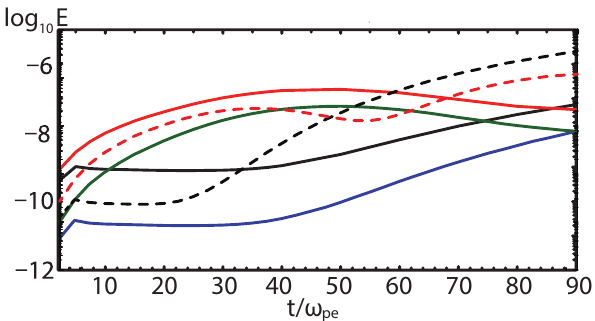
Fig. 4. The panel shows the time evolution of electric field energy (red) and magnetic field energy (black) for γ j = 15 and m i /m e = 20 (Nishikawa et al., 2013). For the case with the real mass ratio the green and blue lines shows the time evolution of electric field en- ergy and magnetic field energy, respectively. The dashed red and black lines show the time evolution of electric field energy and magnetic field energy, respectively for the case with γ j = 1 . 5 and m i /m e = 20. For all cases the kinetic KHI grows quickly, the mag- netic field energy plateaus, and later gradually grows again. In the non-relativistic case the magnetic field energy becomes larger than the electric field energy at an earlier